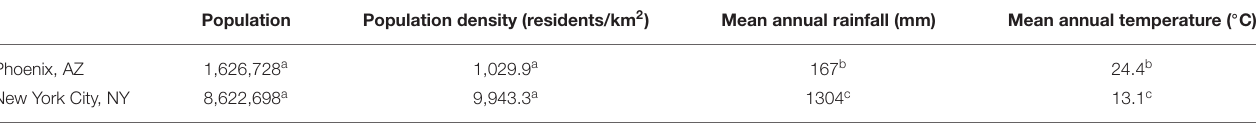
TABLE 1 | Population and climatic characteristics of Phoenix, AZ and New York City, NY.